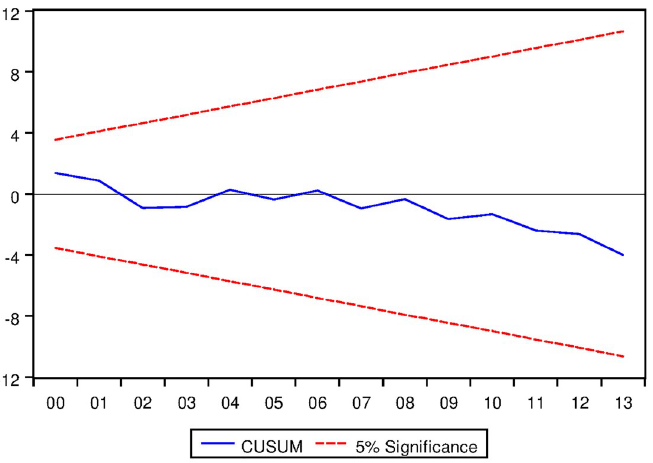
Fig 24. Stability diagnostic of cointegrating relationship for Swiss data with linear trend as fixed regressor under proposed framework.